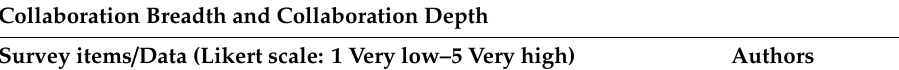
Table 1. Collaboration breadth and depth constructs survey questions.